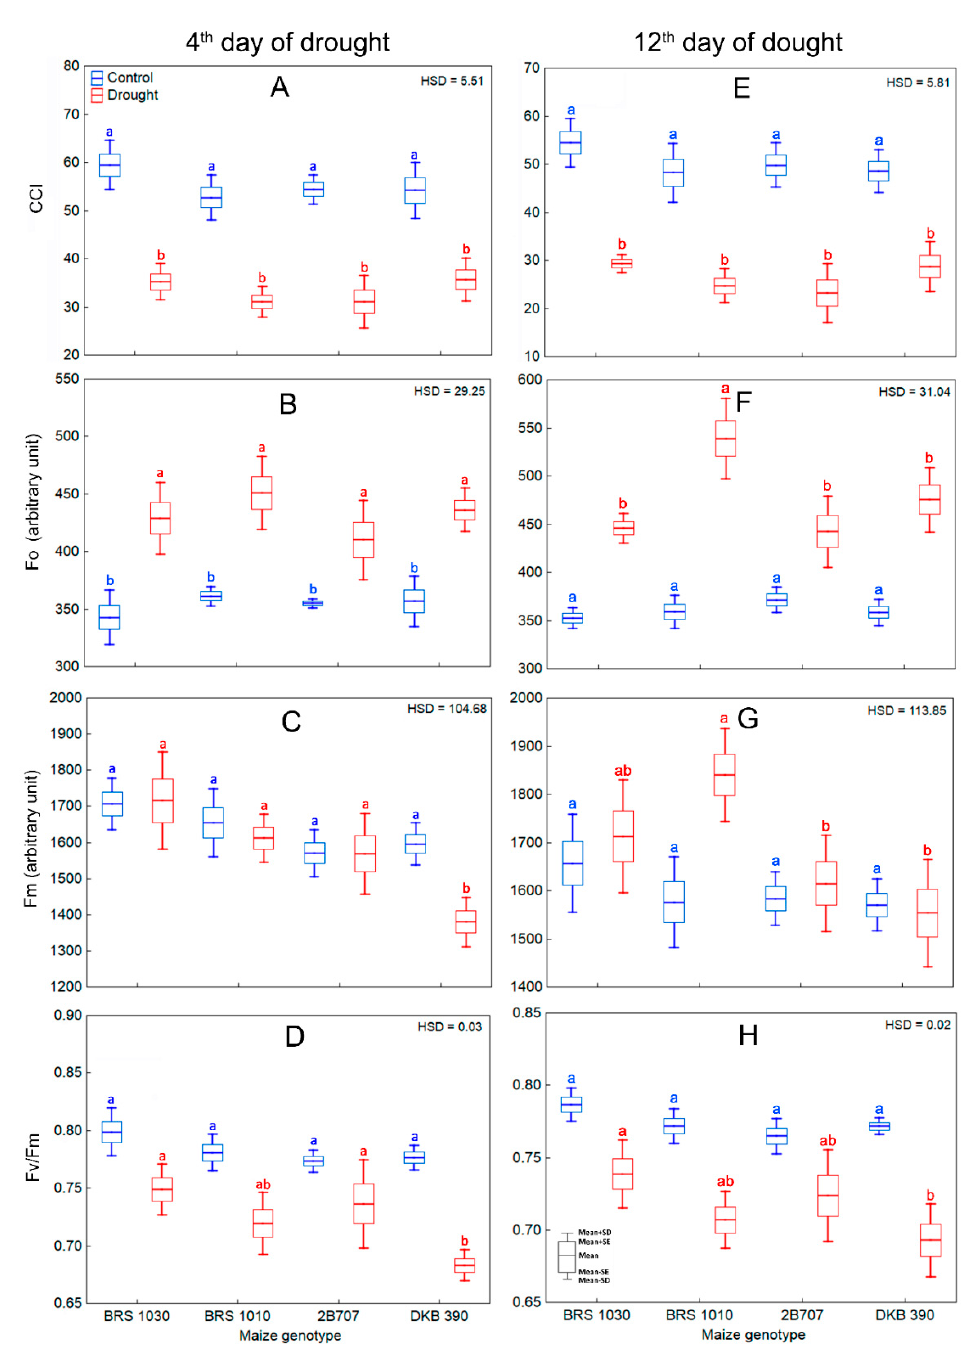
Figure 10. Chlorophyll content and variables derived from chlorophyll fluorescence measurements for control and drought stressed maize plants in the 4 th and 12 th day of stress. ( A,E ) Chlorophyll content index (CCI), ( B , F ) minimum fluorescence yield on dark-adapted leaf (Fo), ( C,G ) maximum fluorescence yield on dark-adapted leaf (Fm), ( D,H ) maximum photosystem II quantum yield (Fv/Fm) in plants of maize genotypes grown in soil at field capacity (control) or subjected to water shortage (drought) at pre-flowering stage. 4 th day: ( A , B ) showed significant differences among treatments regardless of genotype ( p < 0.01), which indicates that the means of the genotypes should be compared between the treatments. Boxes from the same genotype under different treatments, topped by the same letter, are not statistically different according to Tukey’s test ( p < 0.05); C–D showed significant interaction between treatment and genotype ( p < 0.05) which indicates that the means of the genotypes should be compared by treatment. Boxes from different genotypes under the same treatment, topped by the same letter, are not statistically different according to Tukey’s test ( p < 0.05). 12 th day: ( E ) showed significant differences among treatments regardless of genotype ( p < 0.01),